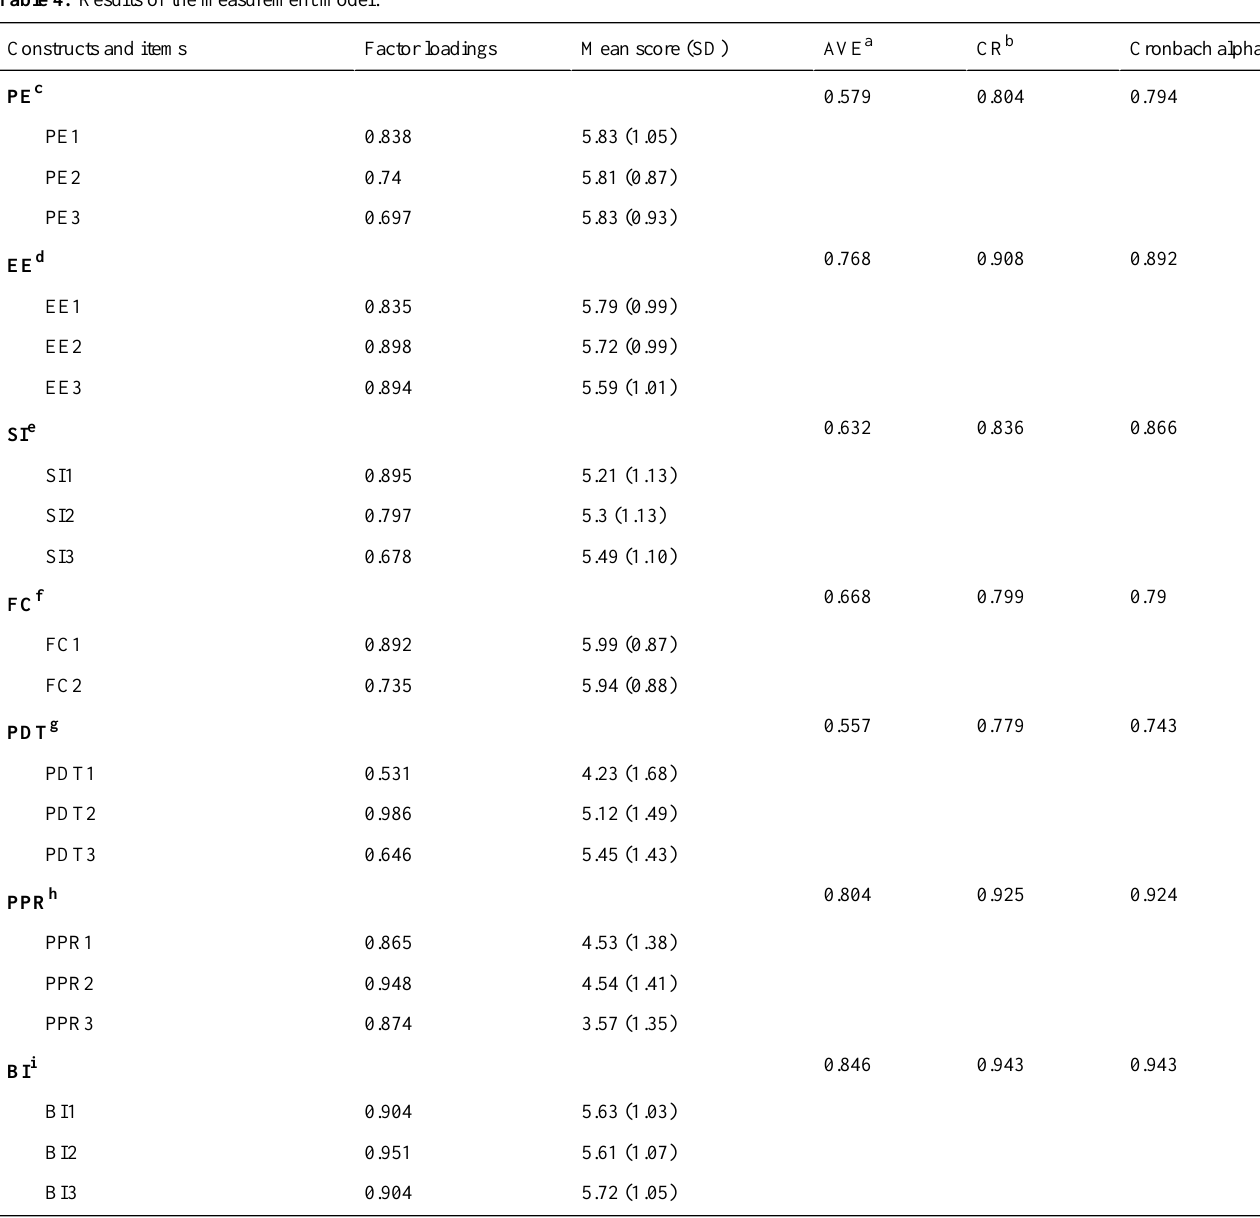
Table 4. Results of the measurement